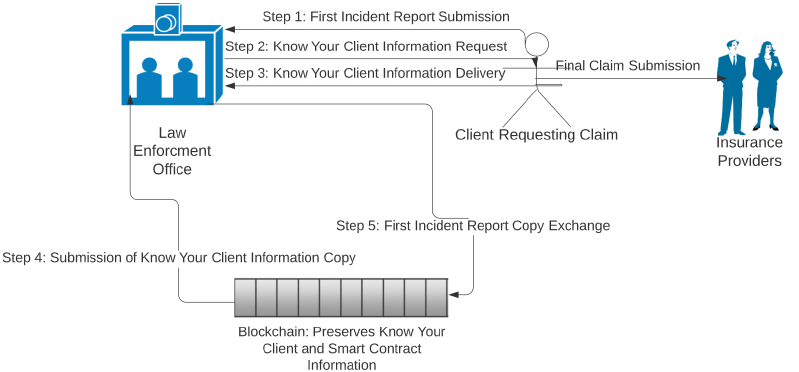
Figure 18. Information on how insurance claim processing and analysis can be benefited through blockchain, inspired by